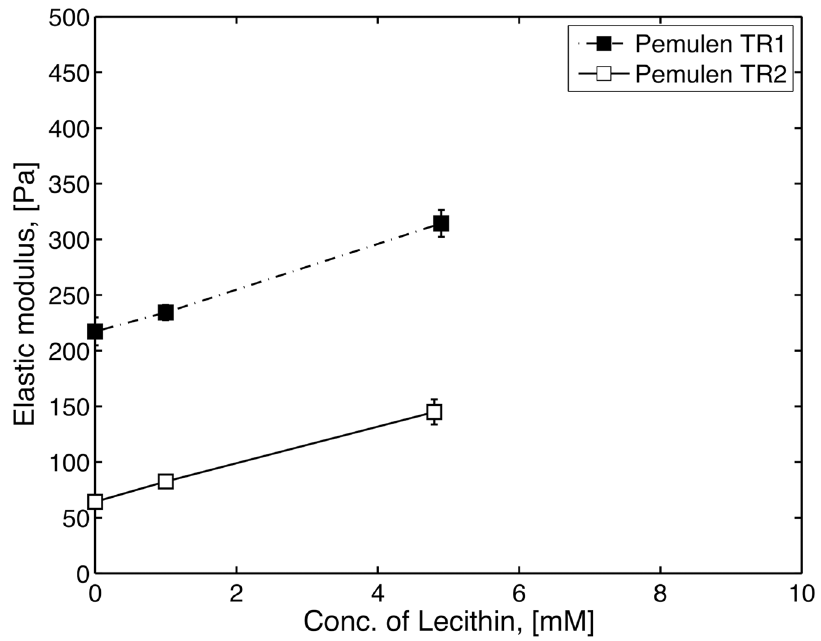
Fig 4. The measure elastic modulus (G ’ ) at 0.2 Hz for homogeneous samples of polymer and lecithin, for 1 wt% Pemulen TR1 (filled square), TR2 (open squares). At lecithin concentrations above 5 mM the systems were not homogenous and were thus not subjected to further characterization. Carbopol, which lacks hydrophobes, formed heterogeneous samples at all concentrations with lecithin. The data points represent the mean values of three samples and error bars show the standard deviation (n =